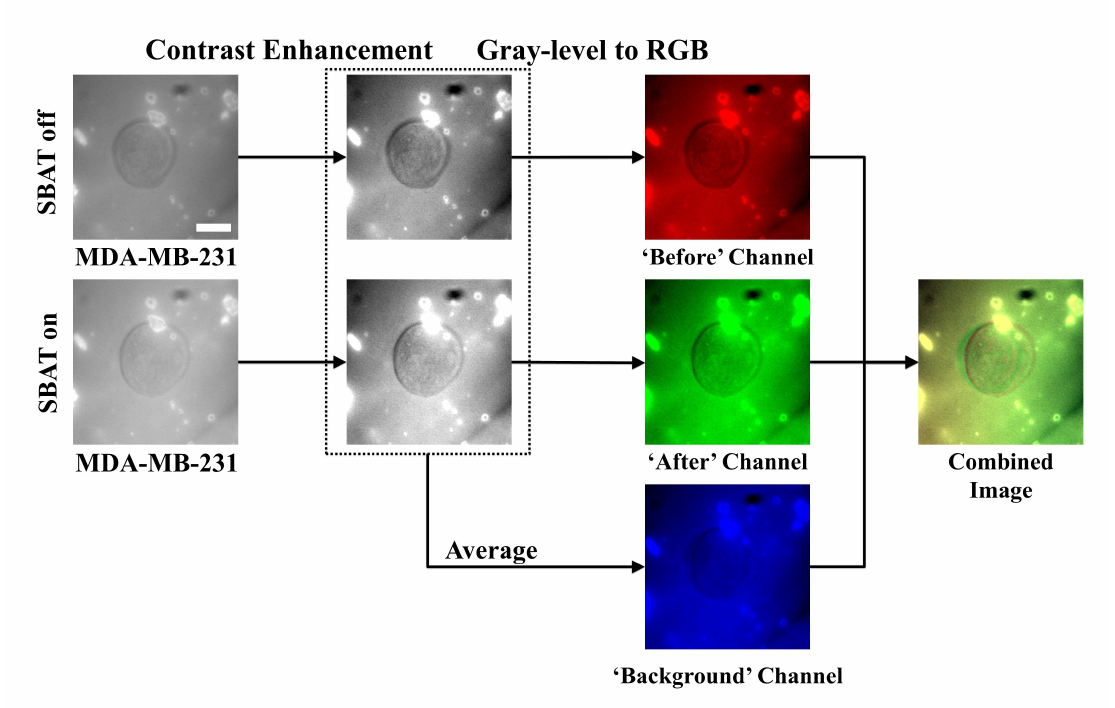
Figure 3. Preprocessing procedures for cell images. The first column presents photomicrographs taken when the SBAT was on and off, displaying the cell membrane deformation with the SBAT. The second column shows the results of the contrast enhancement. In the third column, we composed color channels of the combined image by using the enhanced photomicrographs. First, the red channel corresponds to the predeformation. The green channel exhibits the post deformation. As an average of the red and green channels, the blue channel will show us background areas. The last column is the result of the combination. We applied the same preprocessing method to both more and less deformed cells (MDA-MB-231 and MCF-7). Scale bar indicates 10 µ m.